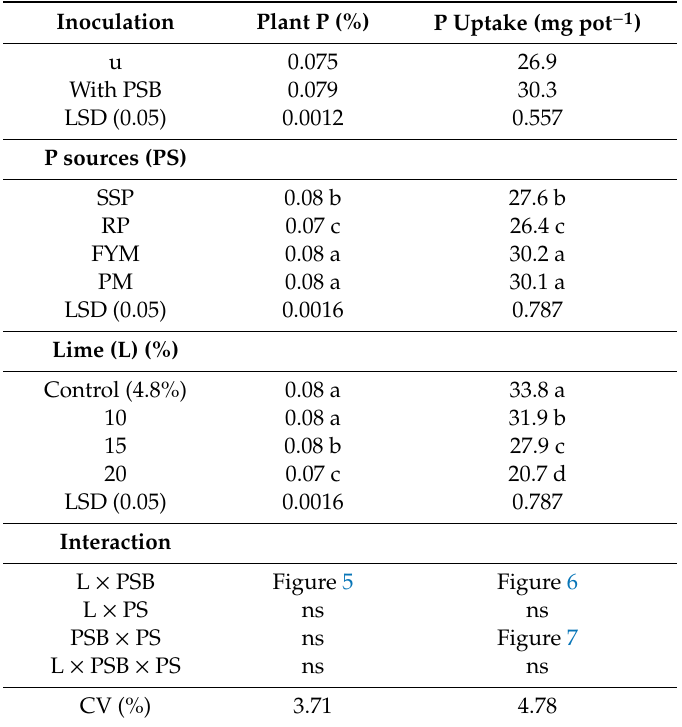
Table 5. Mean comparison of main e ff ects of inoculation, P sources and lime on postharvest plant P concentration and